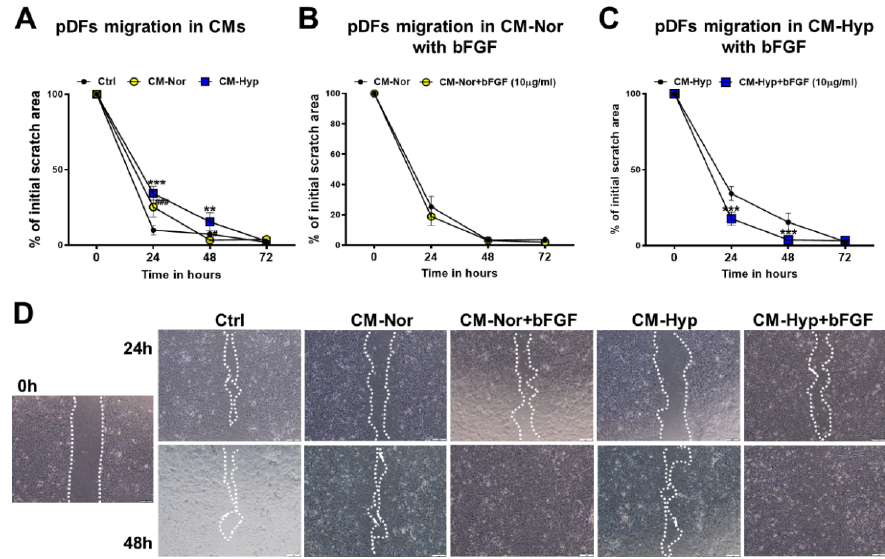
Figure 3. Effect of pASCs-CMs alone or supplemented with bFGF (10 μg/mL) on pDFs migration. Wound healing scratch assay shows decreased migration of pDFs exposed to both CM-Nor and CM-Hyp ( A ). Supplementation of ( B ) CM-Nor with bFGF has no effect on cells’ motility; however, ( C ) bFGF enrichment of CM-Hyp improved cells’ motility at 24 and 48 h. ( D ) Representative pictures demonstrating the stimulatory effect of CMs and bFGF on pDFs’ migratory abilities at different time points (0, 24 and 48 h). The results are shown as the mean ± SD. The asterisks indicate significant differences between CM-Hyp exposed pDFs and control cultures ( A ) or CM-Hyp vs CM-Hyp+ bFGF ( C ) (** p < 0.01; *** p < 0.001). Hashes show significant differences between pDFs cultured in CM-Nor and the control medium ( # p < 0.05; ### p < 0.001). Abbreviations: pASCs, pig adipose-derived